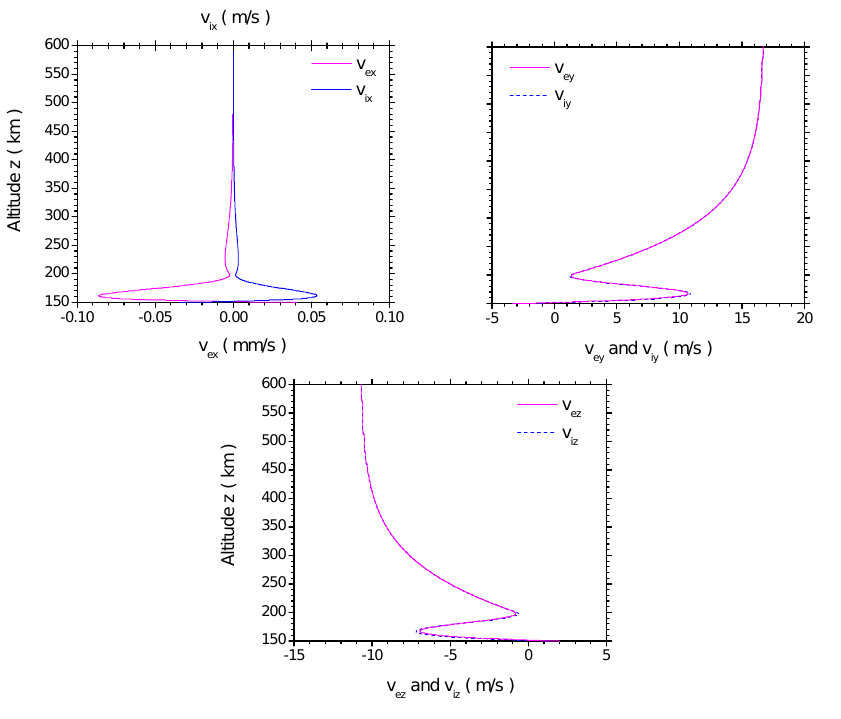
Figure 4. Vertical profiles of ionospheric electron and ion speeds, v left panel), v and v (upper right panel), v ey iy ionospheric dynamo electric field. Equations (48) and (49) are